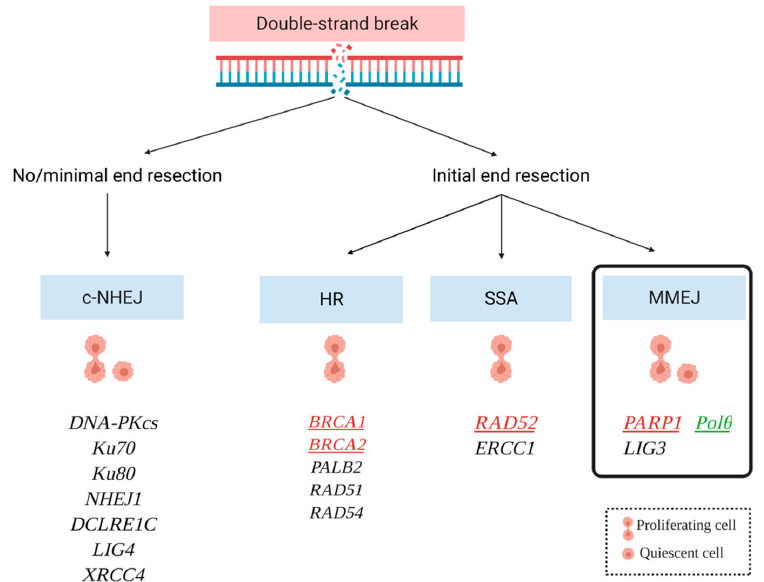
Figure 1. Double-strand break (DSB) repair mechanisms in the quiescent and proliferating cells and major proteins participating in them. Homologous recombination (HR), single-strand annealing (SSA), and microhomology-mediated end joining (MMEJ), in contrast to canonical non-homologous end joining (c-NHEJ), require DNA end resection to expose 3 ′ single stranded DNA fragments. Pol θ as a potential target for synthetic lethality-based therapy has been marked in green. The PARP1, Rad52, BRCA1, BRCA2 partners for dual synthetic lethality have been marked in red.